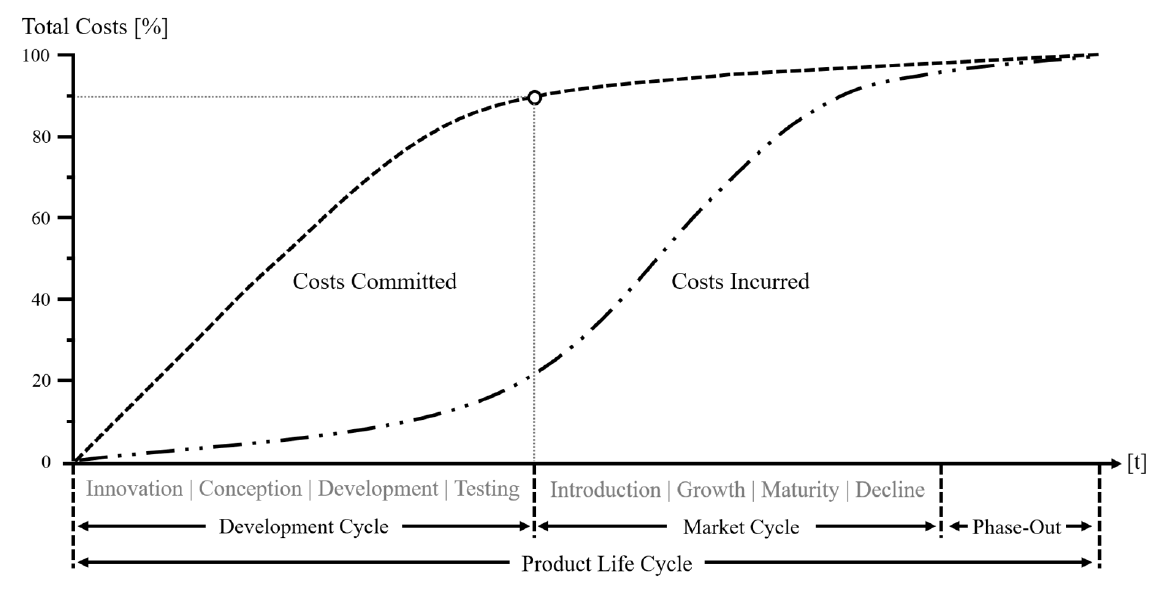
Figure 1. Cost commitment along the product life cycle